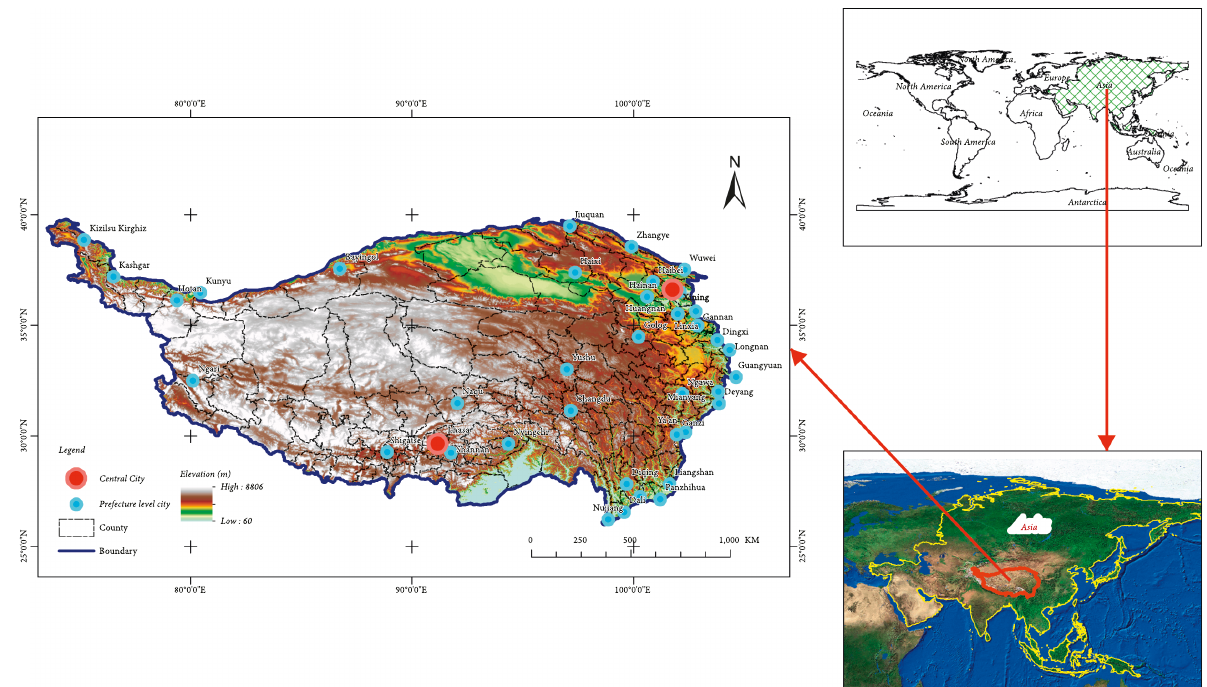
Figure 2: Overview of the Qinghai-Tibet